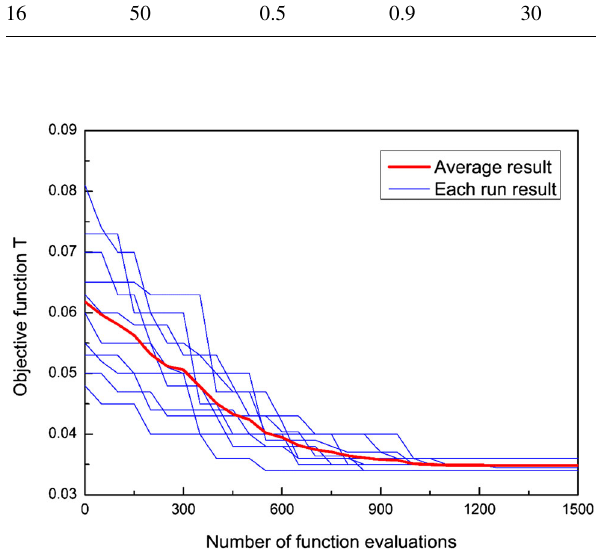
Fig. 5 Convergence curve for all ten runs versus number of simulations